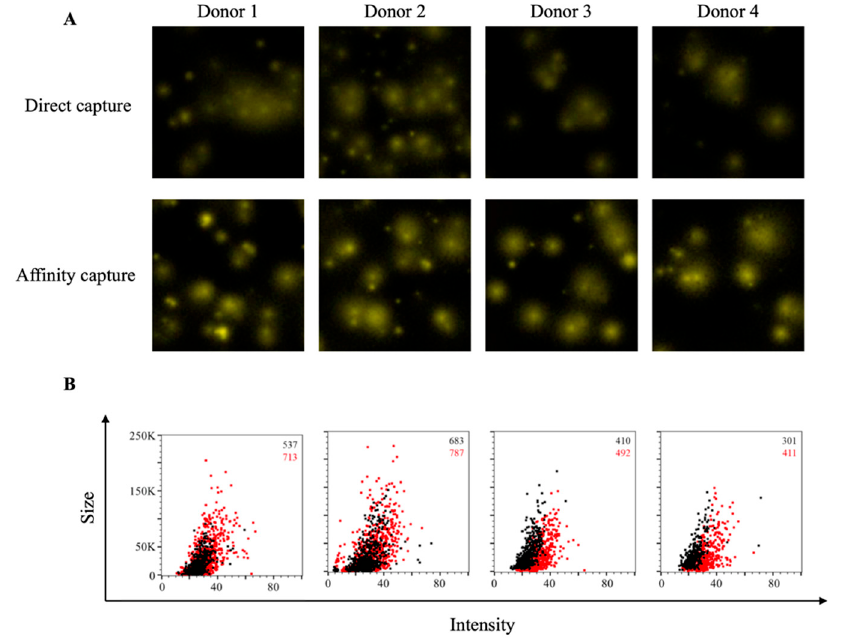
Figure 2. Affinity tag capture improves detection of SARS-CoV-2 S1-reactive ASC. PBMC from four PCR-confirmed COVID-19 donors were stimulated in vitro and evaluated for antibody-secreting (ASC) reactivity against the S1 subunit of the SARS-CoV-2 Spike protein. ( A ) Representative well images depicting antigen-specific IgG + ASC in wells coated directly with 10 μ g/mL of S1 protein or through affinity capture using the genetically encoded hexahistidine (6XHis) tag. Magnification and contrast enhancements were uniformly performed on all images to aid their visualization in publication. ( B ) S1-specific FluoroSpots were merged into FCS files and visualized as bivariate plots. FluoroSpots originating from assay wells in which S1 protein was directly captured on the membrane (black dots) or through affinity capture (red) are shown as overlays. The combined number of FluoroSpots detected in replicate wells for each of the respective donors is indicated in the inset using the same red/black color code.